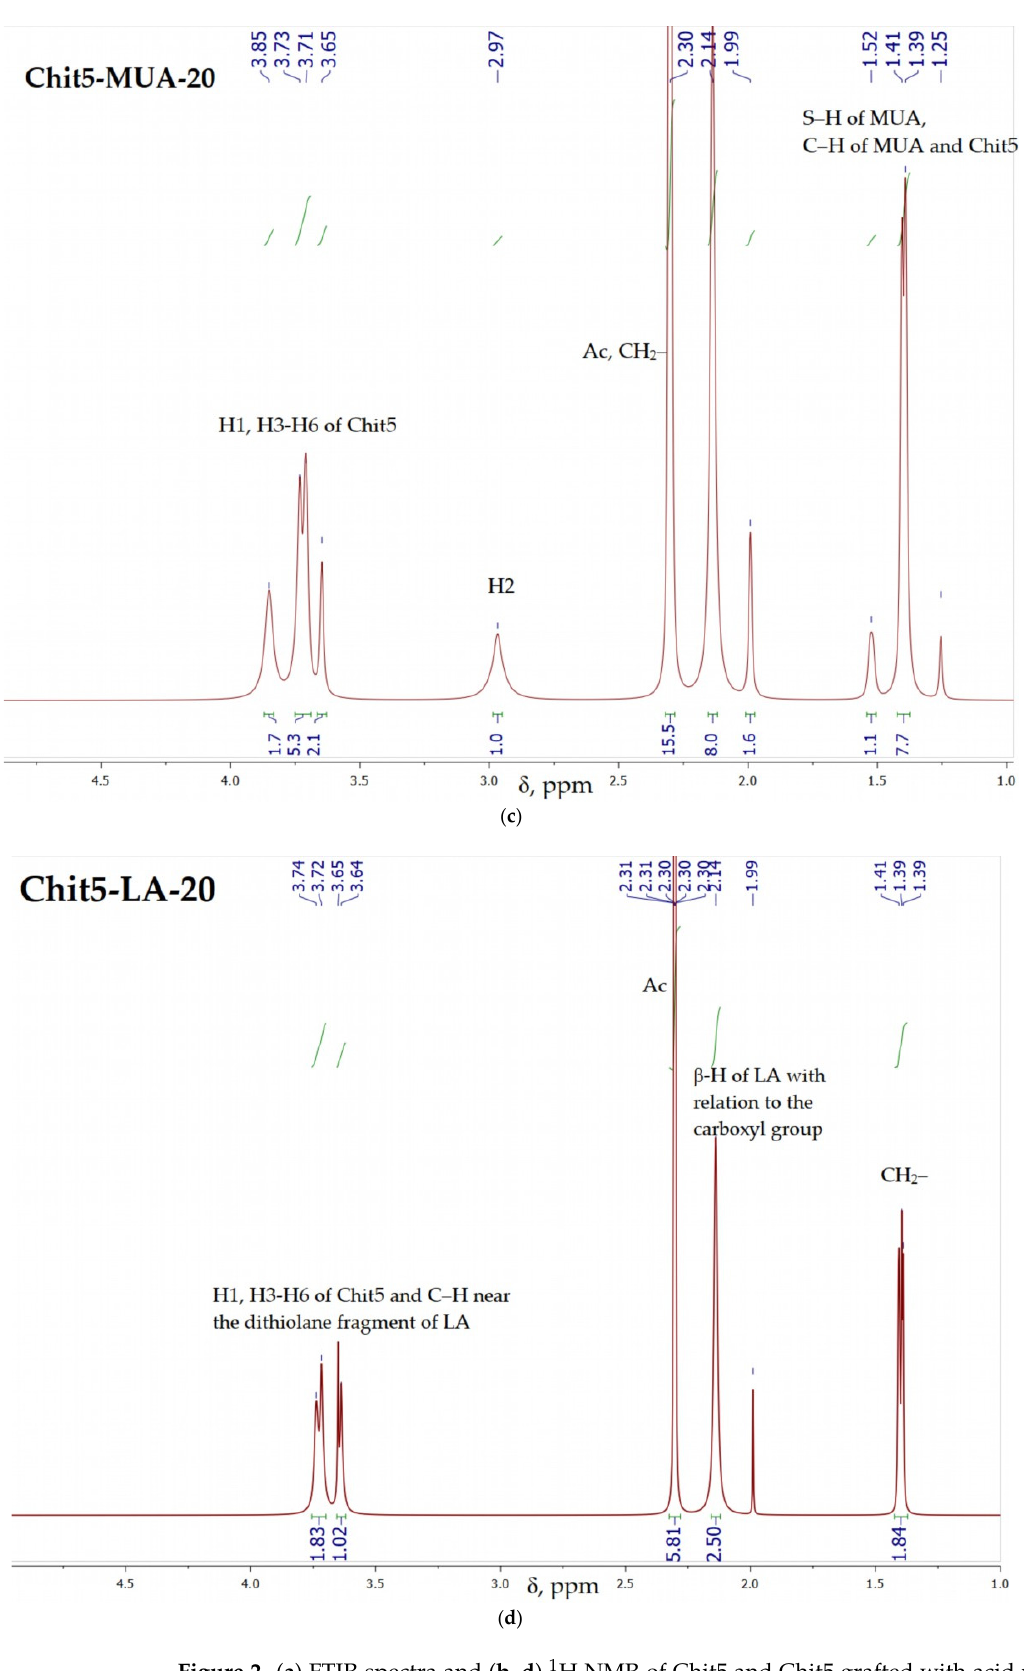
Figure 2. ( a ) FTIR spectra and ( b – d ) 1 H NMR of Chit5 and Chit5 grafted with acid residues. PBS (0.01 M, pH = 7.4). T = 22 °C. Based on FTIR spectroscopy data (integral peak intensities), nanoparticle tracking analysis, TNBS amino-group titration (Figure 3), and initial component ratios, the average modification degrees and chemical composition of conjugates were determined (Table 1). The degree of acid grafting of chitosan varied from 12 to 20% (the theoretical maximum possible degree of modification of amino groups according to the method is 20%). This corresponds to the modification of one chitosan molecule with 3–7 residues of oleic, stearic, 11-mercaptoundecanoic, or lipoic acids. Depending on the acid residue, polymer micelles will have different properties: hydrodynamic size, packing density, drug interaction, and CMC. However, in general, all polymers turned out to comply with the standard in terms of micelles formation. According to the literature data, an increase in the degree of chitosan modification to a certain value (up to 30–40%) [2,11,28– 30,41,43,44,55] improves micelle formation due to the compaction of the hydrophobic core and, consequently, the thermodynamically more preferable inclusion of aromatic drugs. A small degree of modification causes a loose core and a larger micelle size. With a decrease in the length of the fatty acid residue, the size of micelles decreases, however, in the case of MUA, disulfide bonds inside micelles can form, increasing the size of micelles (Table 1).